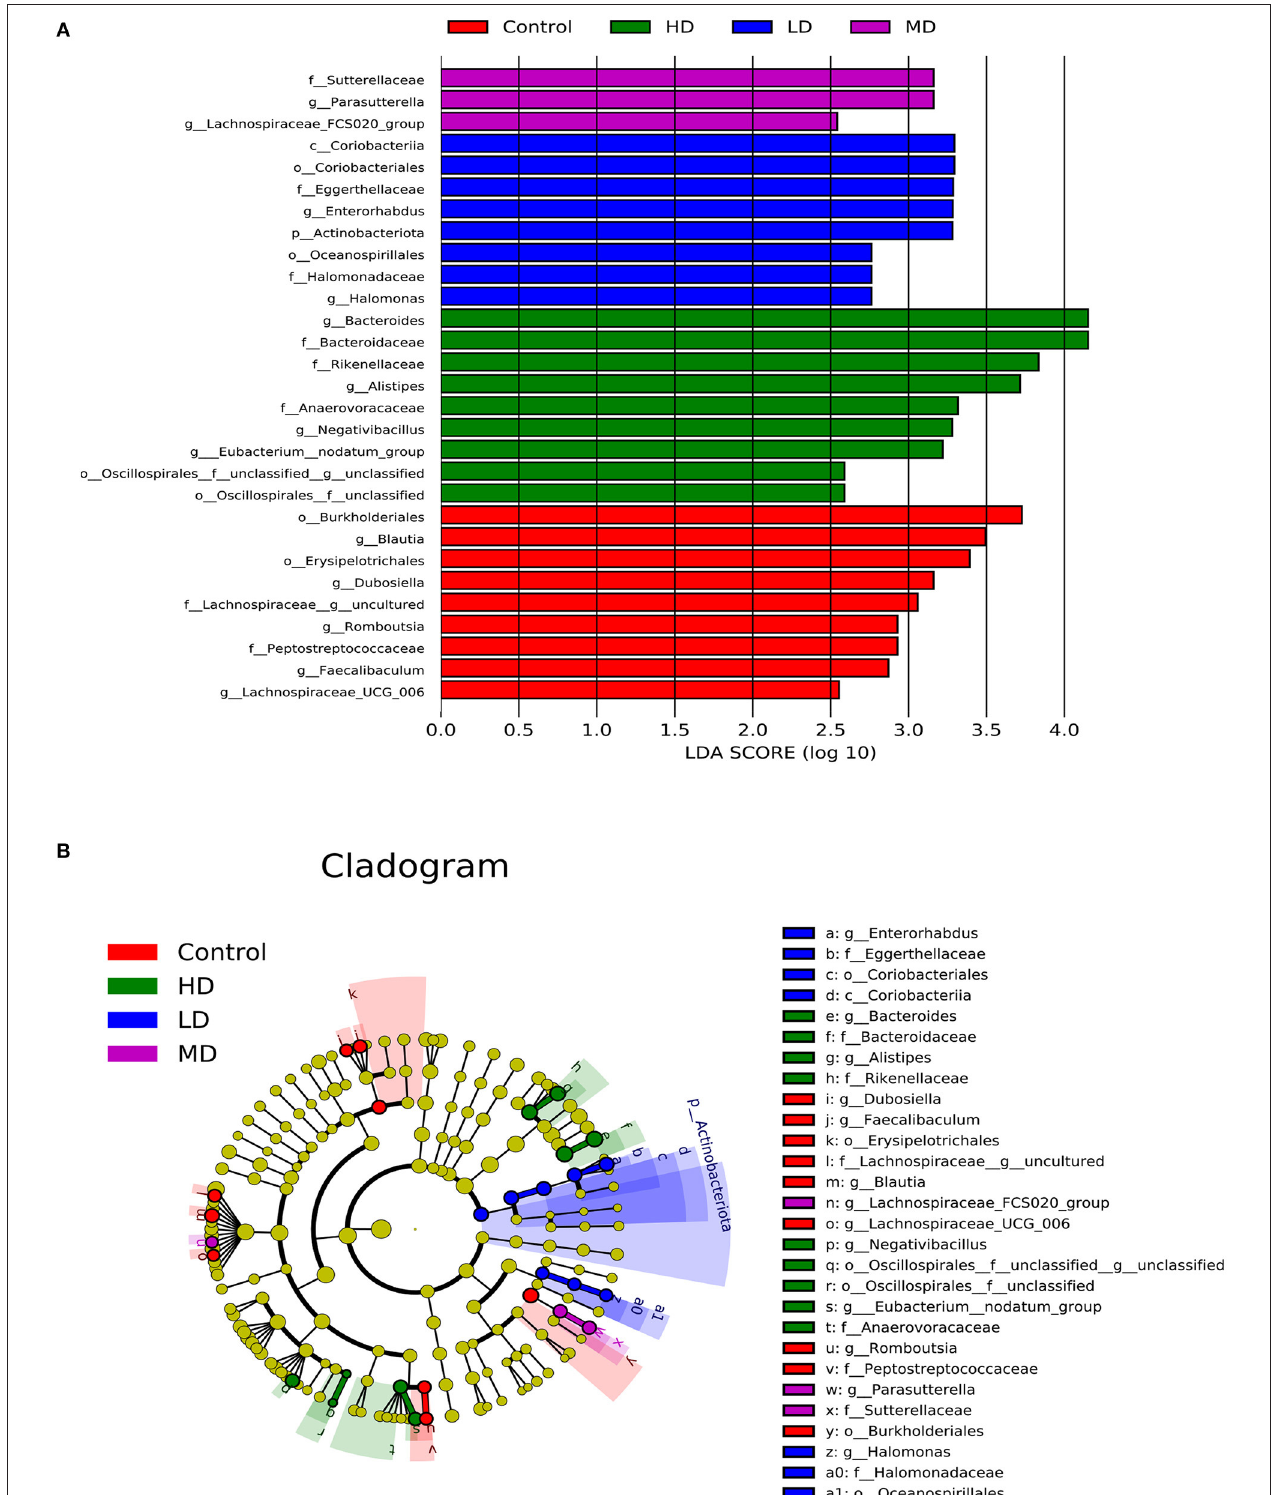
FIGURE 3 | Characteristics of microbial community composition using LEfSe (LDA Effect Size) analysis. (A) The differential bacteria of the gut microbiota meeting a significant LDA threshold value of > 2.5 between groups with different levels of red meat diet. (B) The cladogram based on LEfSe shows differential bacteria of the gut microbiota between groups with different levels of red meat